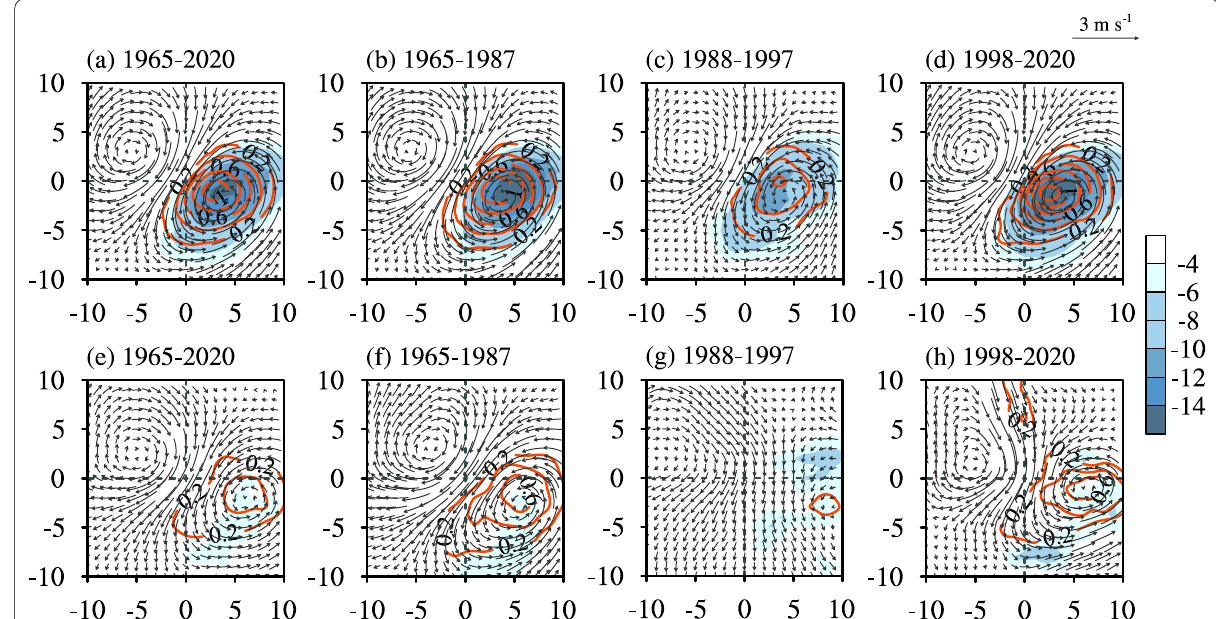
Fig. 8 The composite 3–8-day bandpass filtered 850-hPa relative vorticity (10 –5 s − 1 ; contours), OLR (W m − 2 ; shaded), and 850-hPa wind field (m s − 1 ; vectors) for the 1 day prior to the TC genesis for developing disturbances ( a – d ), TCs without precursory disturbances ( e – h ) in different decades. The center in ( a – h ) is the location of the TC genesis. The interval of contours is from 0.2